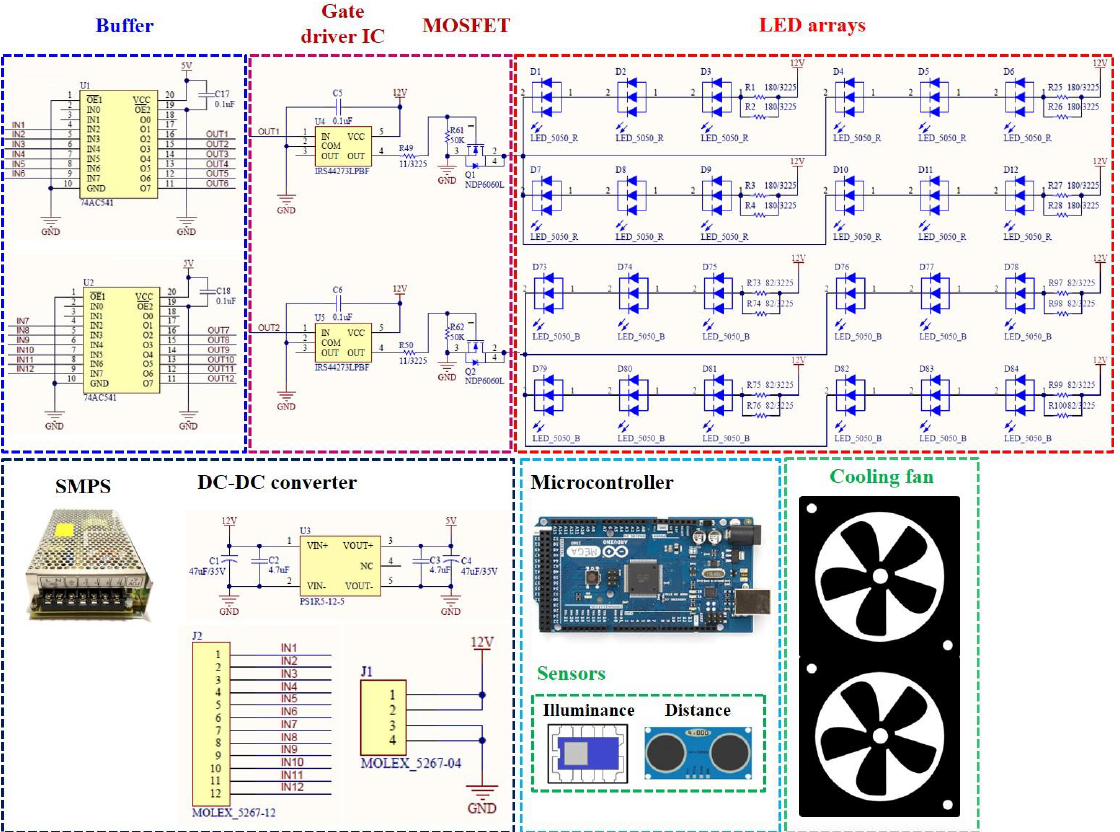
Figure 4. The overall circuit diagram of the proposed system.